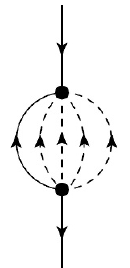
Figure 10 . Leading order quantum corrections to the fermionic propagator in a model of f 6 (cid:8) 6 interaction in 3 + 1